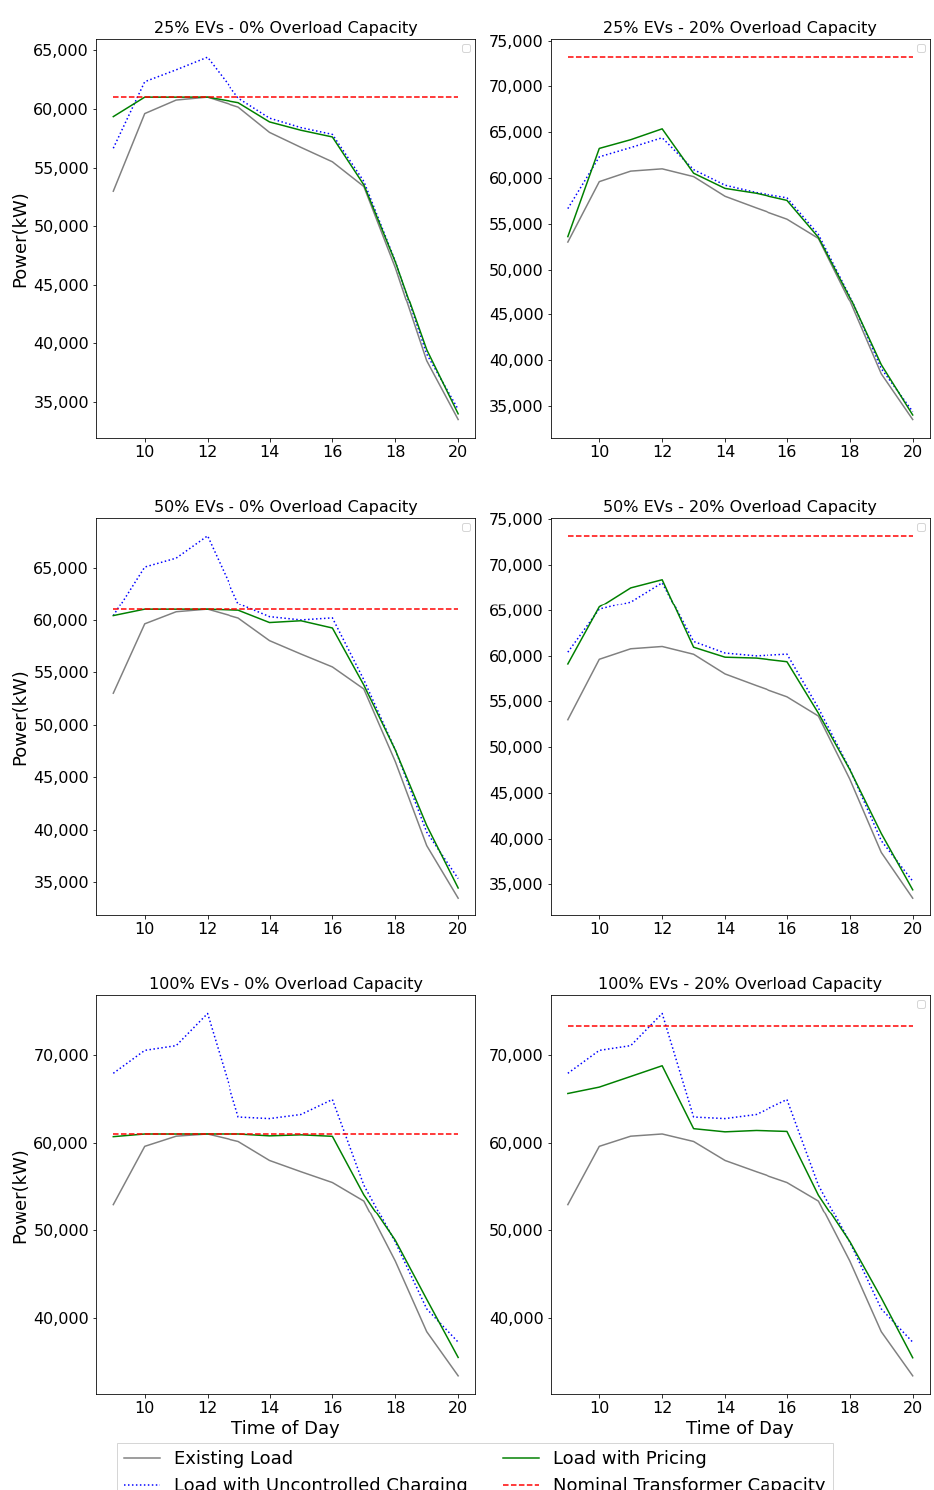
Figure 8. Charging allocation analysis for Electric Vehicle (EV) market penetration and overload capacity (Canary Wharf area). The red dotted line represents the nominal capacity of the distribution transformer; the grey line, the baseline load demand; the blue dotted line, the uncoordinated charging scenario; and the green line, the charging allocation with Fixed Pricing based on time of day (FP).